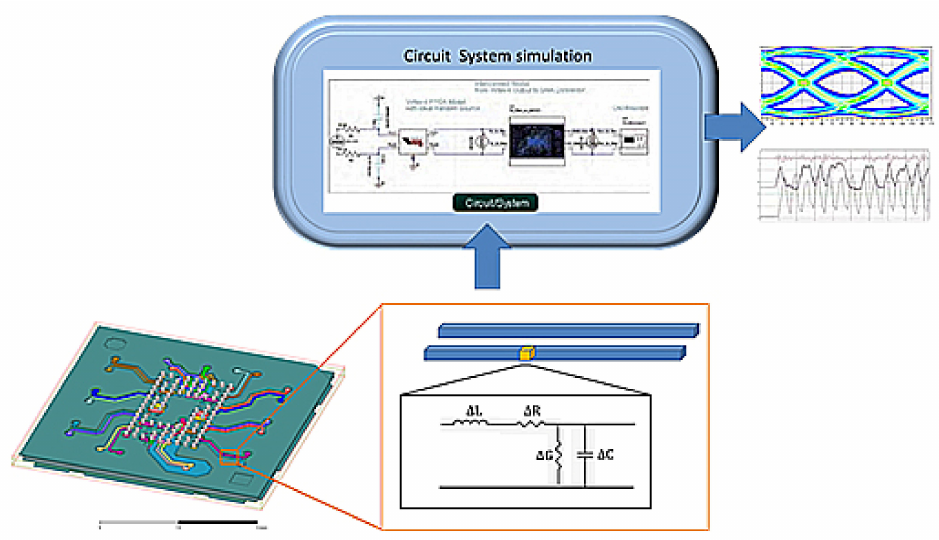
Figure 3. The illustration of RLC model system simulation and verification provided by SPIL (Siliconware Precision Industries Co., Ltd., Taichung City,